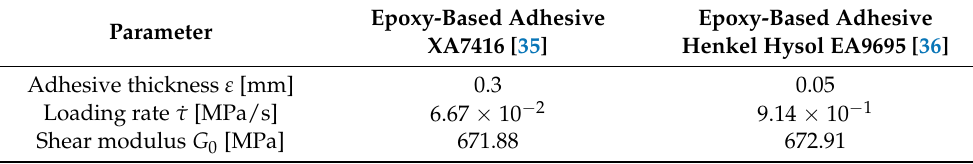
Table 1. Experimental parameters of the structural adhesives in joint